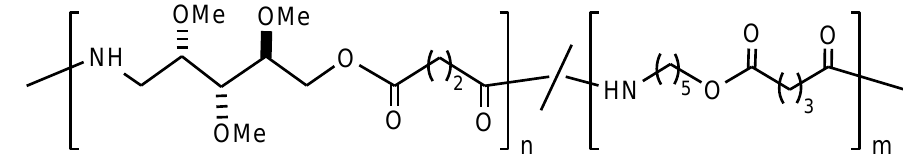
Figure 20. Chemical structure of copoly(ester amide)s containing L-arabinose, succinyl and glutaryl units.